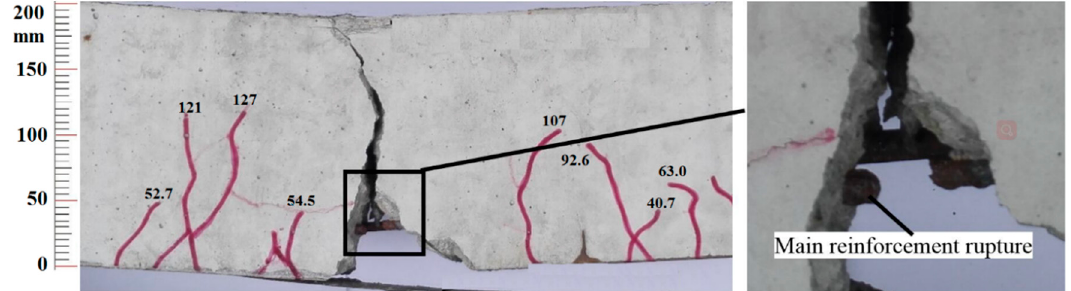
Figure 9. Fatigue failure mode (main steel bar fracture) of the strengthened beam (unit: mm).